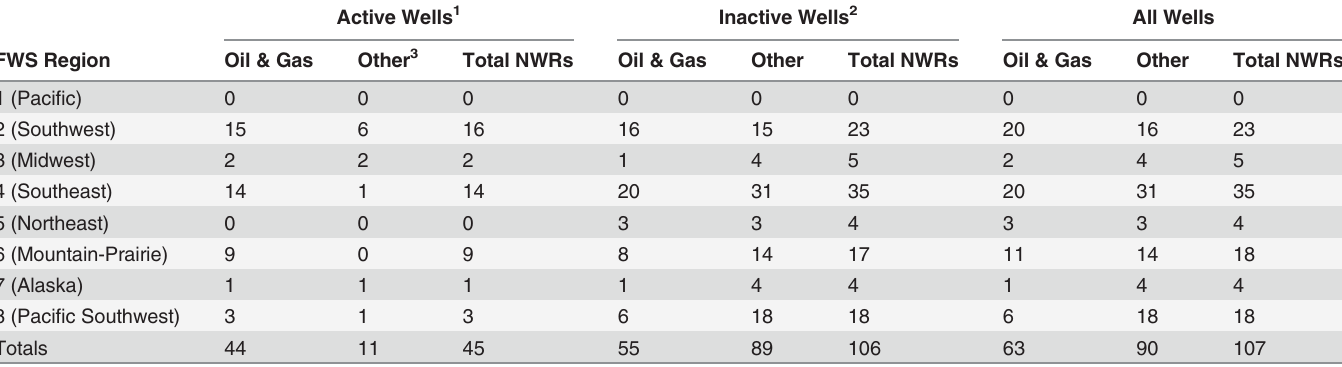
Table 1. Number of NWRS units (NWRs), listed by FWS region, with wells associated with oil and gas exploration and production within fee inter- est boundaries.